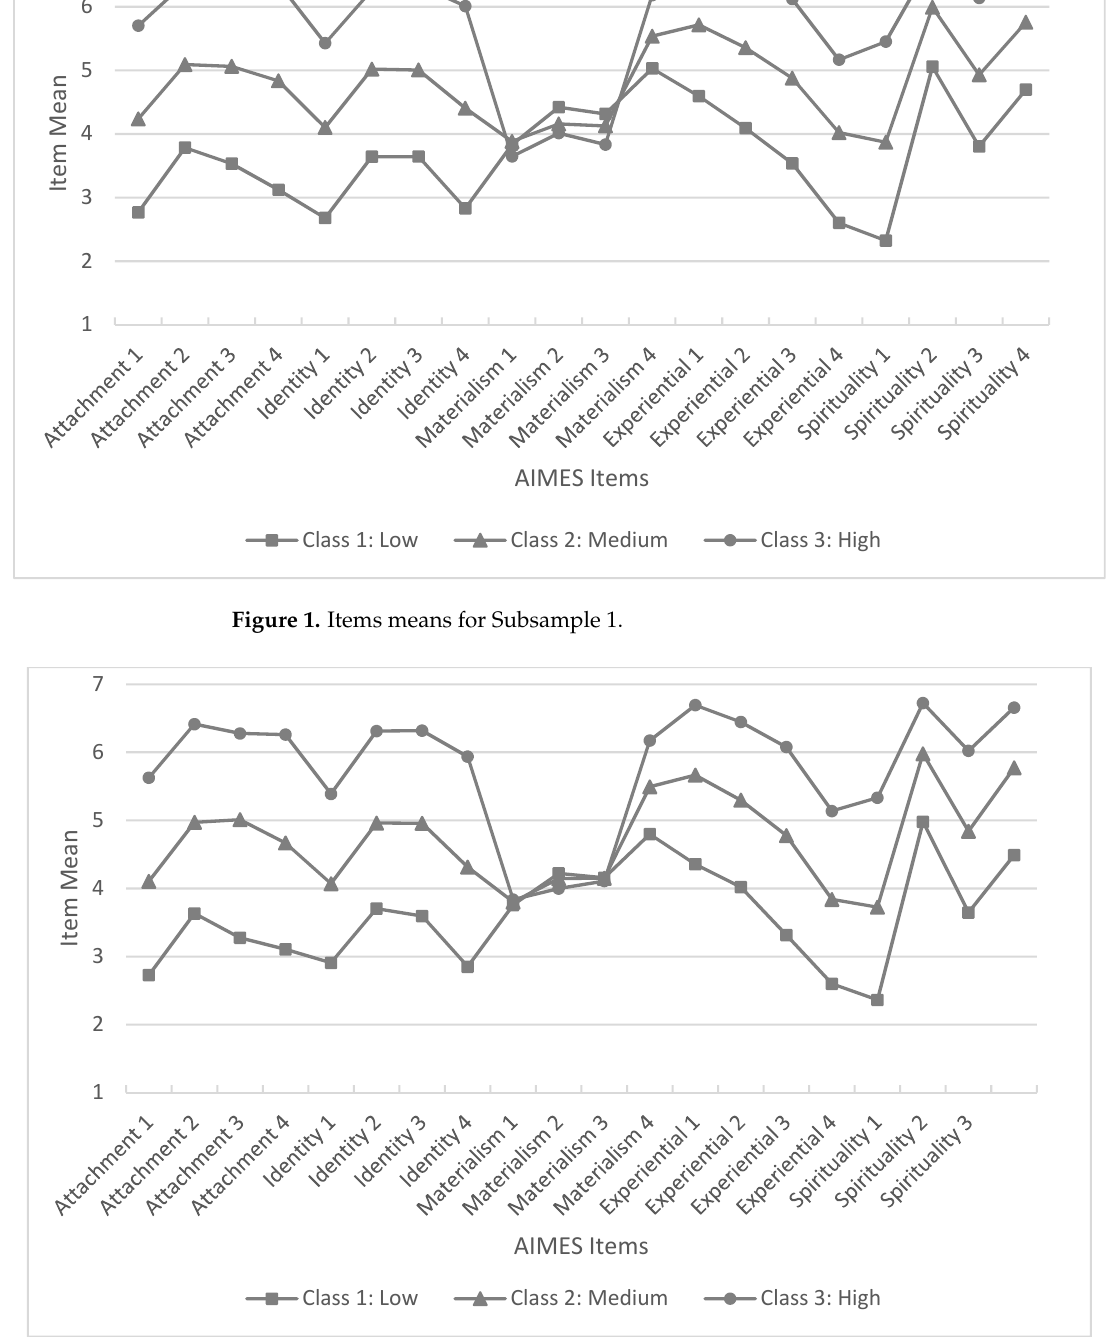
Figure 2. Items mean for Subsample 2.